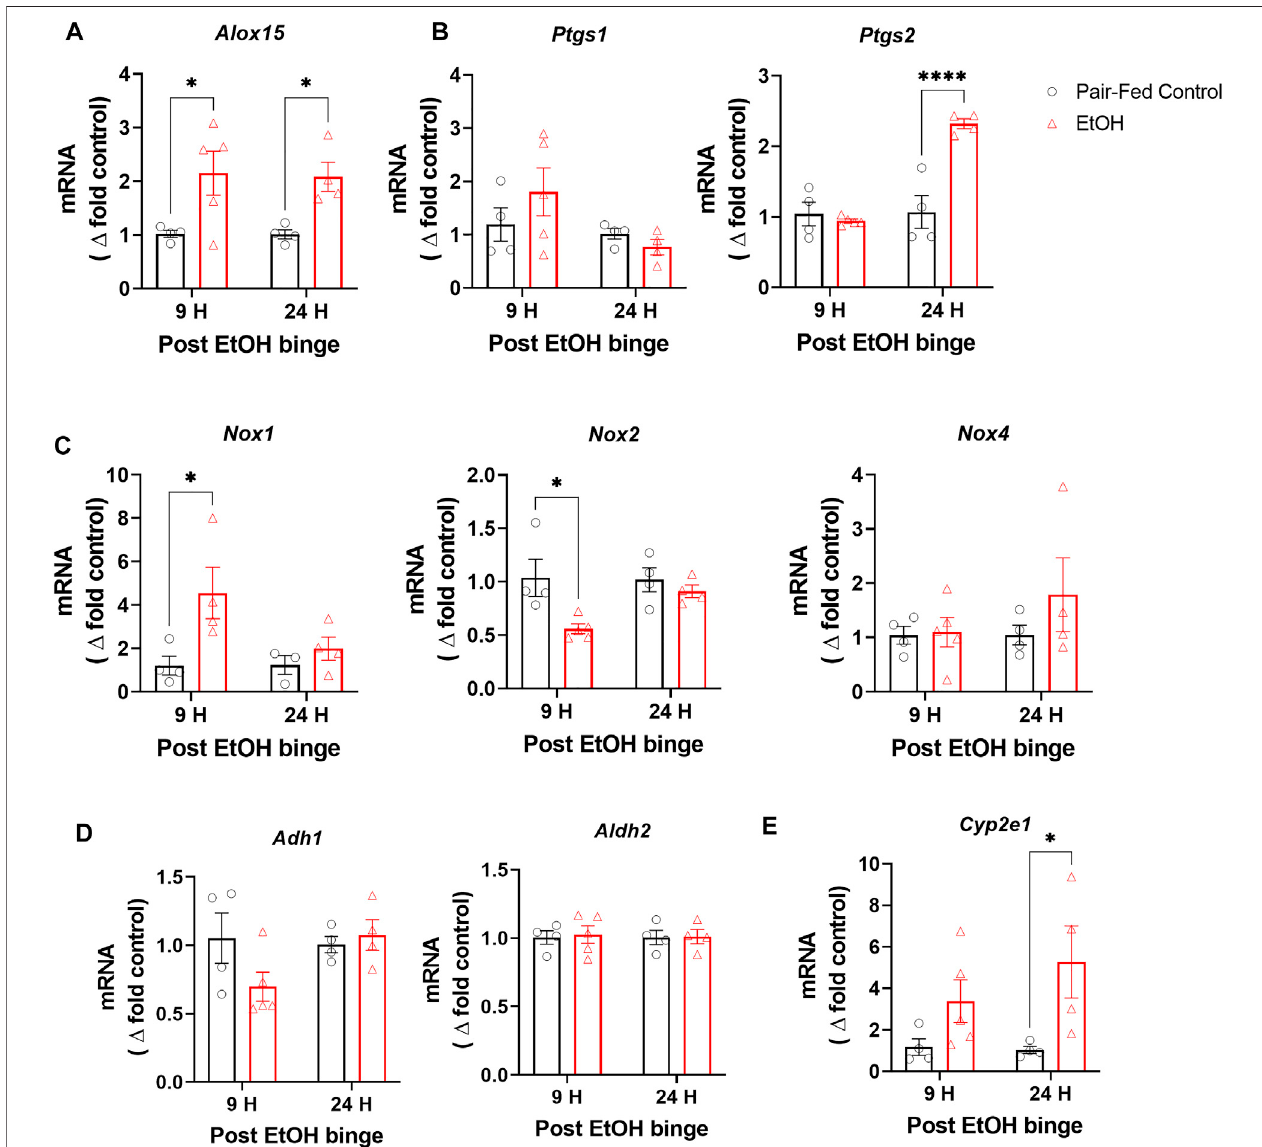
FIGURE 2 | Chronic and single binge ethanol feeding increased expression of oxidative enzymes in mouse lungs. Gene expression of oxidative enzymes arachidonate 15-lipoxygenase (Alox15) (A) , Prostaglandin synthase 1 and 2 (Ptgs1 and Ptgs2) (B) , NADPH oxidase 1, 2 and 4 (Nox1, Nox2 and Nox4) (C) , Alcohol dehydrogenase1(Adh1)andAlcoholdehydrogenase2(Aldh2) (D) ,CytochromeP4502E1(Cyp2E1) (E) inlungseitherpair-fedorethanolfedmice.Datarepresentmean +S.E.M from 4-5 mice per group. Data wereanalyzedby one-way ANOVA followed by Dunnett ’ smultiple comparisons test. * ( p < 0.05), ****( p < 0.0001) indicates signi fi cant difference from the pair-fed control